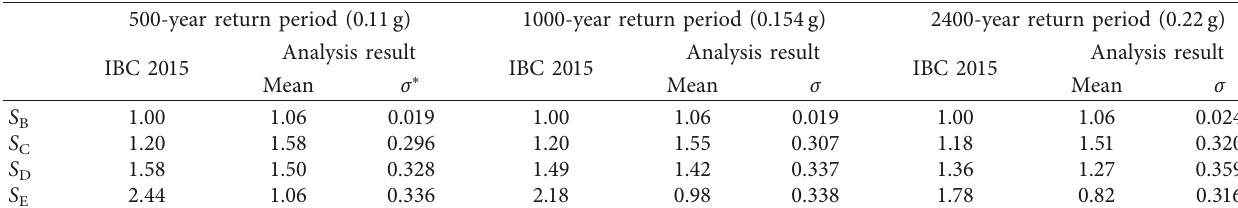
Figure 11: Response spectrum resulting from numerical analysis of four S E sites with depth to bedrock: (a) 30.5m. (b) 37.0m. (c) 40.3m. (d) 50.7m. Table 3: Short-period amplification factor (DRS-1).